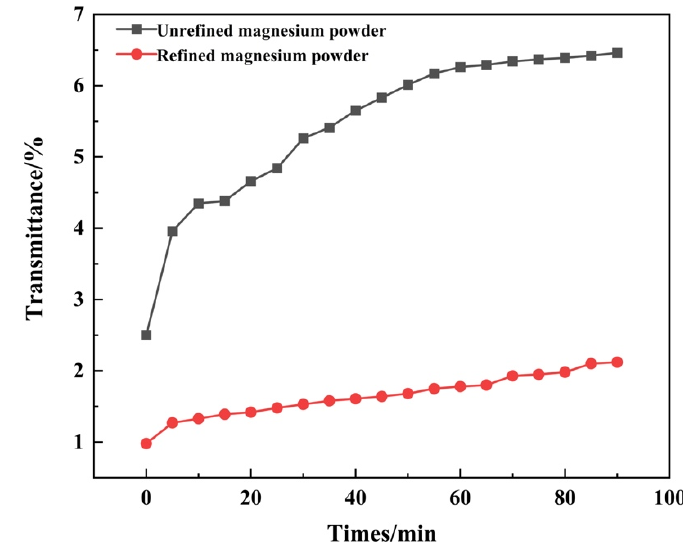
Figure 4. Transmittance–time curve of modified magnesium powder.